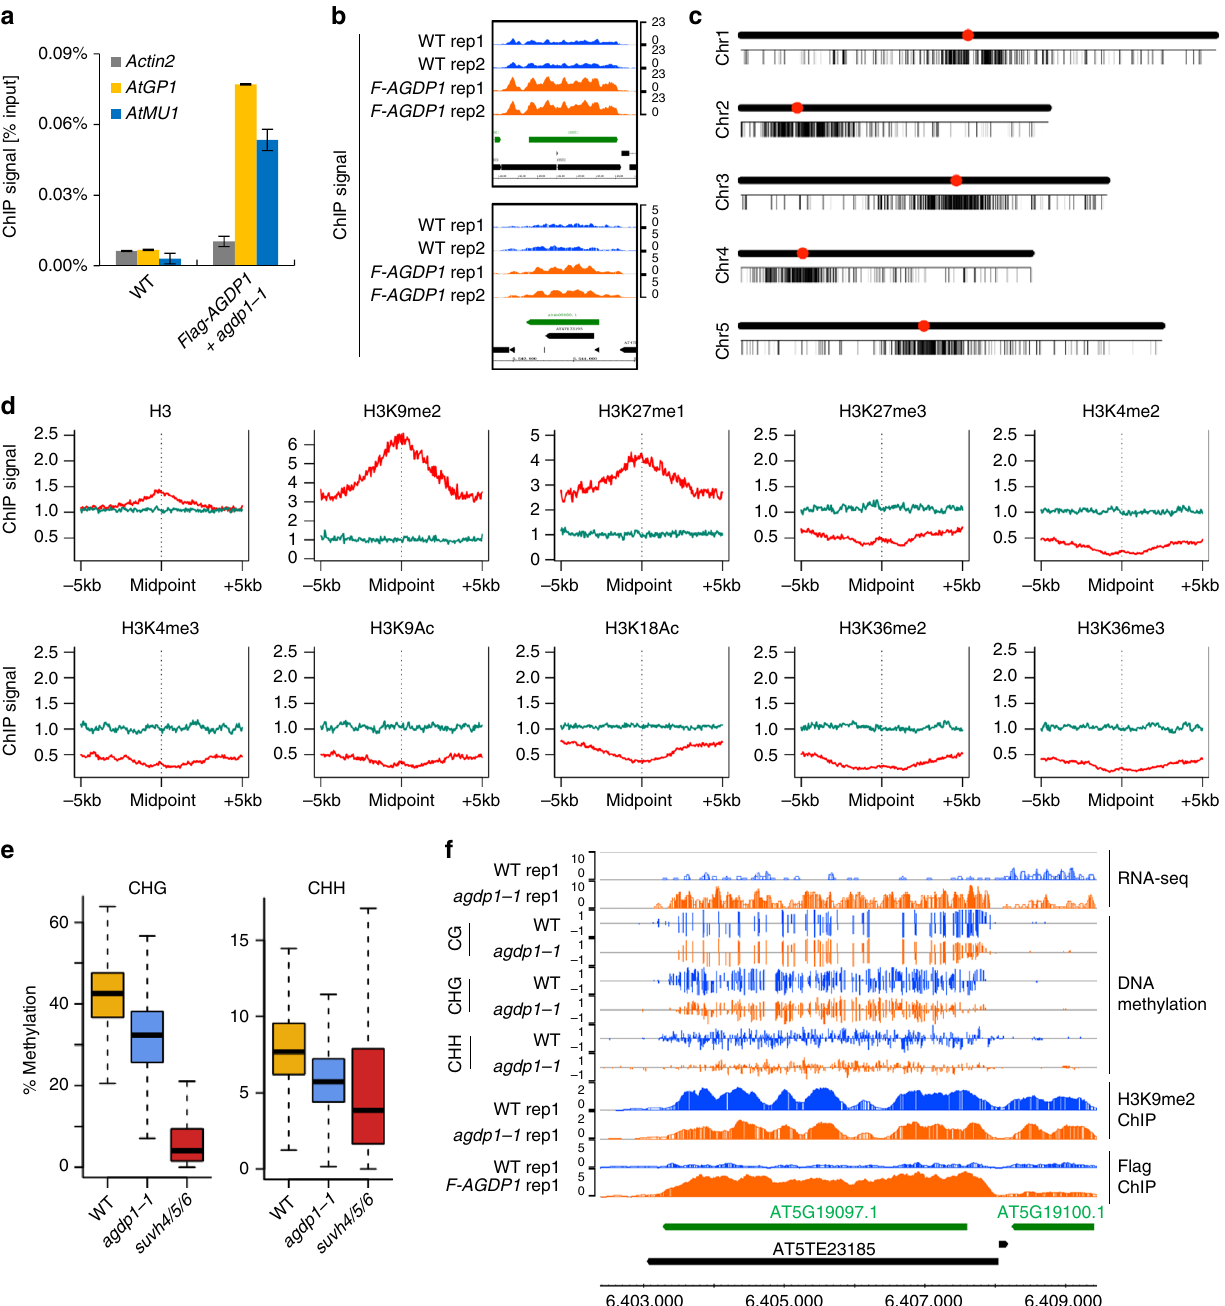
Fig. 6 AGDP1 is enriched in heterochromatin. a AGDP1 is enriched at AtGP1 and AtMU1 as determined by ChIP-qPCR. ChIP signals were quanti fi ed relative to input DNA. Actin2 was used as a negative control locus. Error bars are SDs of three biological replicates. b ChIP-seq results show that AGDP1 is enriched at AtGP1 (upper) and AtMU1 (lower). Two replicates of ChIP-seq data from Flag-AGDP1 transgenic plants and from wild-type control plants are shown. The y axis is normalized read counts per million. The normalization factor is calculated by the total mapped reads. c The distribution of AGDP1-enriched peaks throughout the fi ve chromosomes. Black bars represent AGDP1 peaks. Red circles indicate centromeres. d Association of different histone modi fi cations at regions surrounding the AGDP1 peaks. Simulation regions (green) served as control regions. e Box plots representing CHG and CHH methylation levels of 1914 AGDP1-binding regions. f RNA expression, DNA methylation, H3K9me2 levels, and AGDP1 enrichment at a representative region. The y axis is normalized read counts per million (ChIP-seq) or ten million (RNA-seq). The normalization factor is calculated by the total mapped (Fig. 1e) and sequence alignment results indicate that the AGD12, AGD34, and AGD56 can each capture an H3K9me2 mark using the same mechanism (Fig. 3b). This feature can enhance the binding of AGDP1 to the H3K9me2-enriched heterochromatin region, providing the biochemical basis for our observation of the enrichment of AGDP1 in the H3K9me2-associated long TEs.